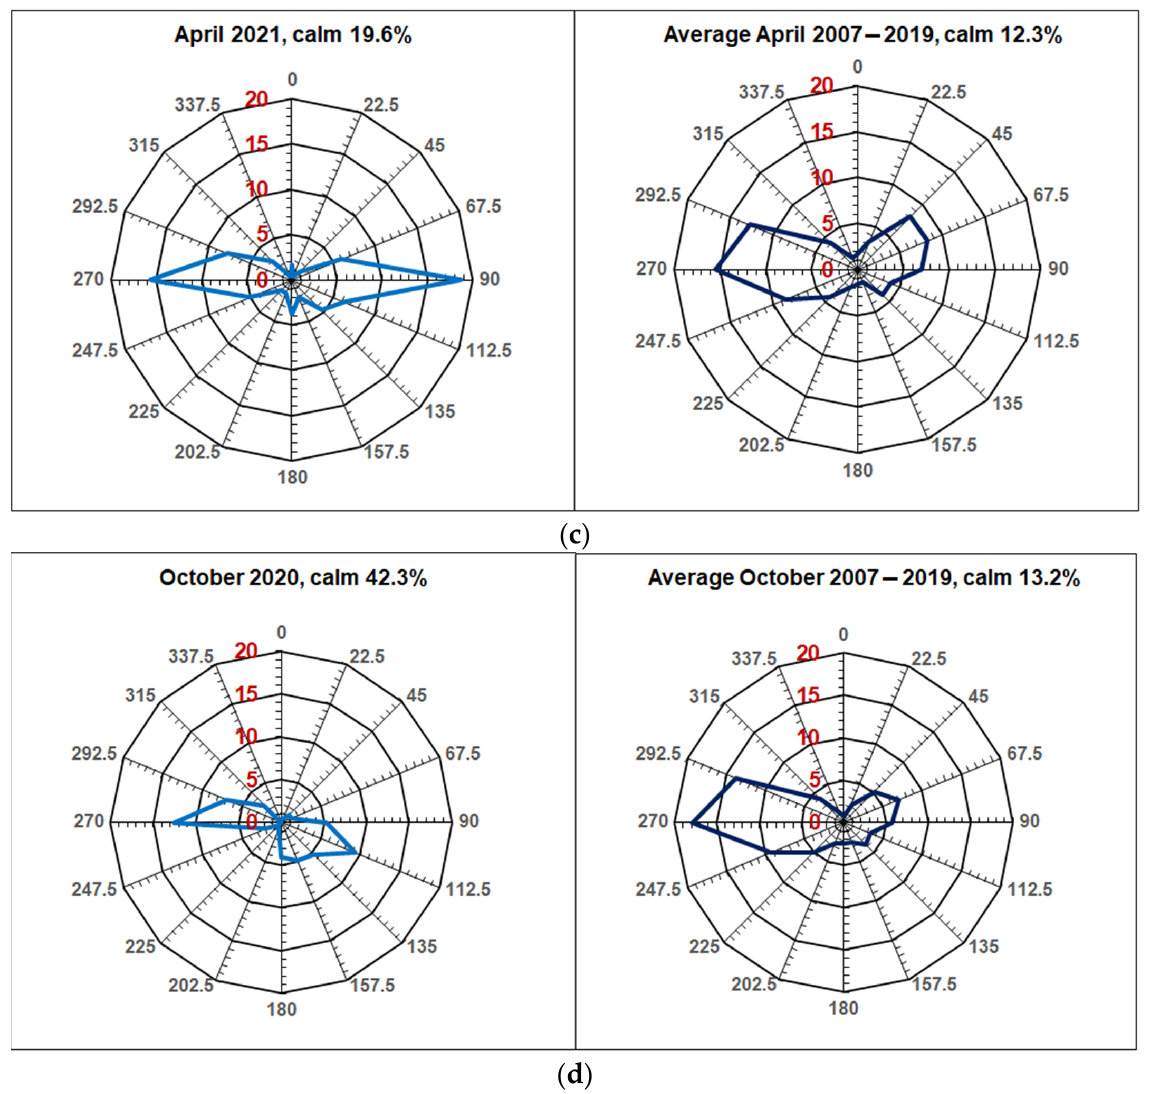
Figure 4. Wind roses: on the left–the average for the month; on the right-the average for the same month for 2007–2019. The percentage of calm conditions is indicated on each picture. The series of diagrams ( a – d ) refer to the episodes 1, 2, 4, 6 (Table 1 and Figure 1), respectively.